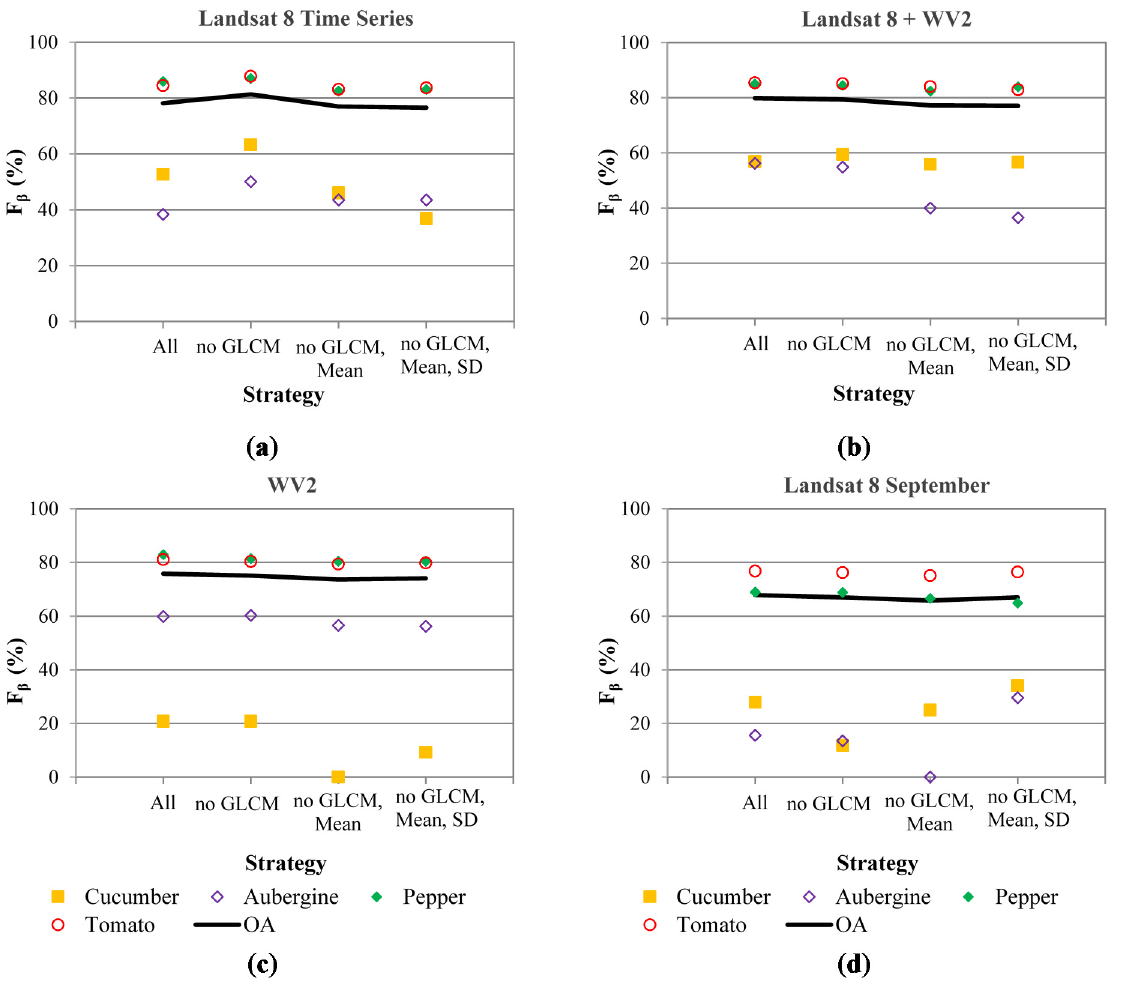
Figure 4. Per-class accuracy given by the corresponding F β index and overall accuracy (OA) using different groups of features and data sources. ( a ) Landsat 8 time series (eight orthoimages); ( b ) Landsat 8 time series plus WV2 single orthoimage; ( c ) WV2 single orthoimage taken on September 30; ( d ) Image Landsat 8 taken on September